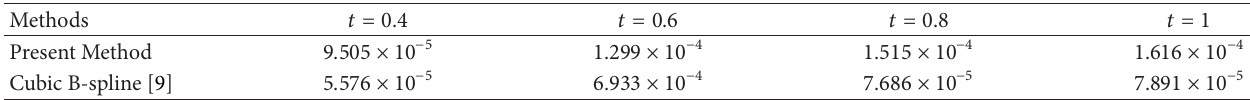
Table 9: The 𝐿 ∞ errors compared with cubic B-spline quasi-interpolation method at different times with 𝑑𝑥 = 0.002 , 𝑑𝑡 = 0.0005 in [0,1] and IMQ RBF ( 𝑐 = 0.02